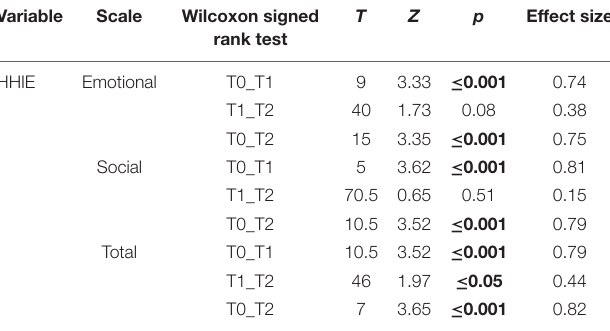
TABLE 5B | Effect size for HHIE comparisons at pre-intervention (T0), 1-month (T1) and at 6-month (T2) follow-up.